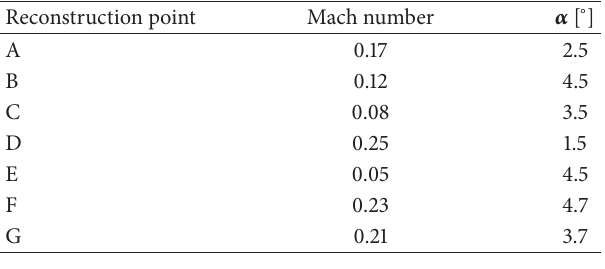
Table 2: NACA 0012 airfoil. List of the reconstruction combina- tions.